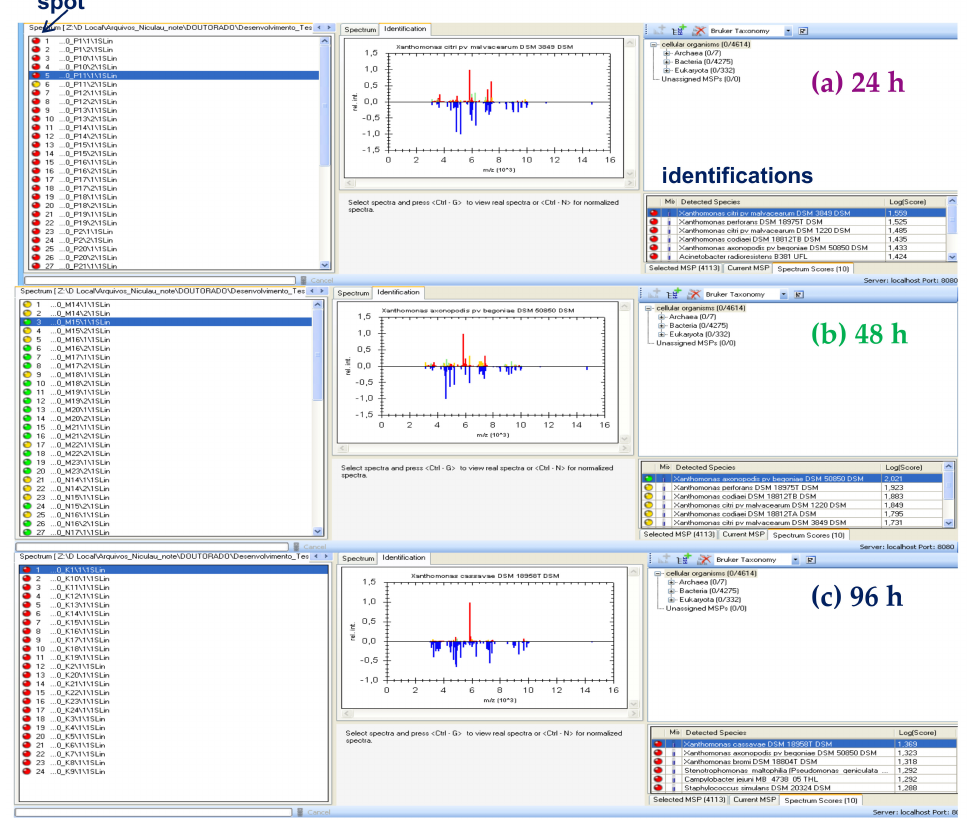
Figure 3. Diagnosis of Xcc by MALDI-TOF/MS using the software MALDI Biotyper after plating onto NBY agar medium in 24 ( a ), 48 ( b ), and 96 ( c )